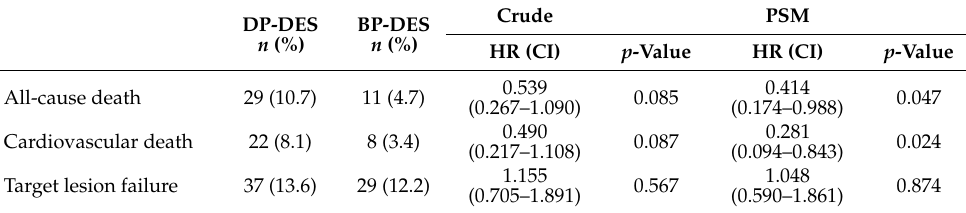
Table 2. Clinical endpoints before and after adjustment using propensity score matching.